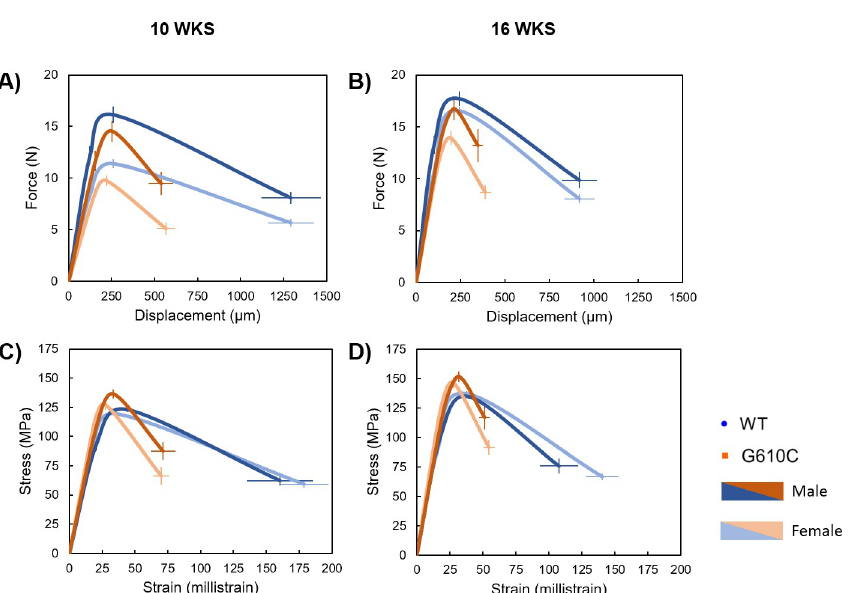
Fig 4. Schematic mechanical curves from femoral 3-pt bending tests. A) Average force-displacement plot for 10-week mice, showing weaker G610C bones with significant deficiencies in postyield and total displacement. B) Strength and deformation disparities continued with the 16-week bones. C) Average stress-strain plots for 10-week mice demonstrate that G610C tissue breaks at lower strains than WT bones. D) This brittle phenotype is maintained at 16-weeks of age. Data points are mean values +/- standard